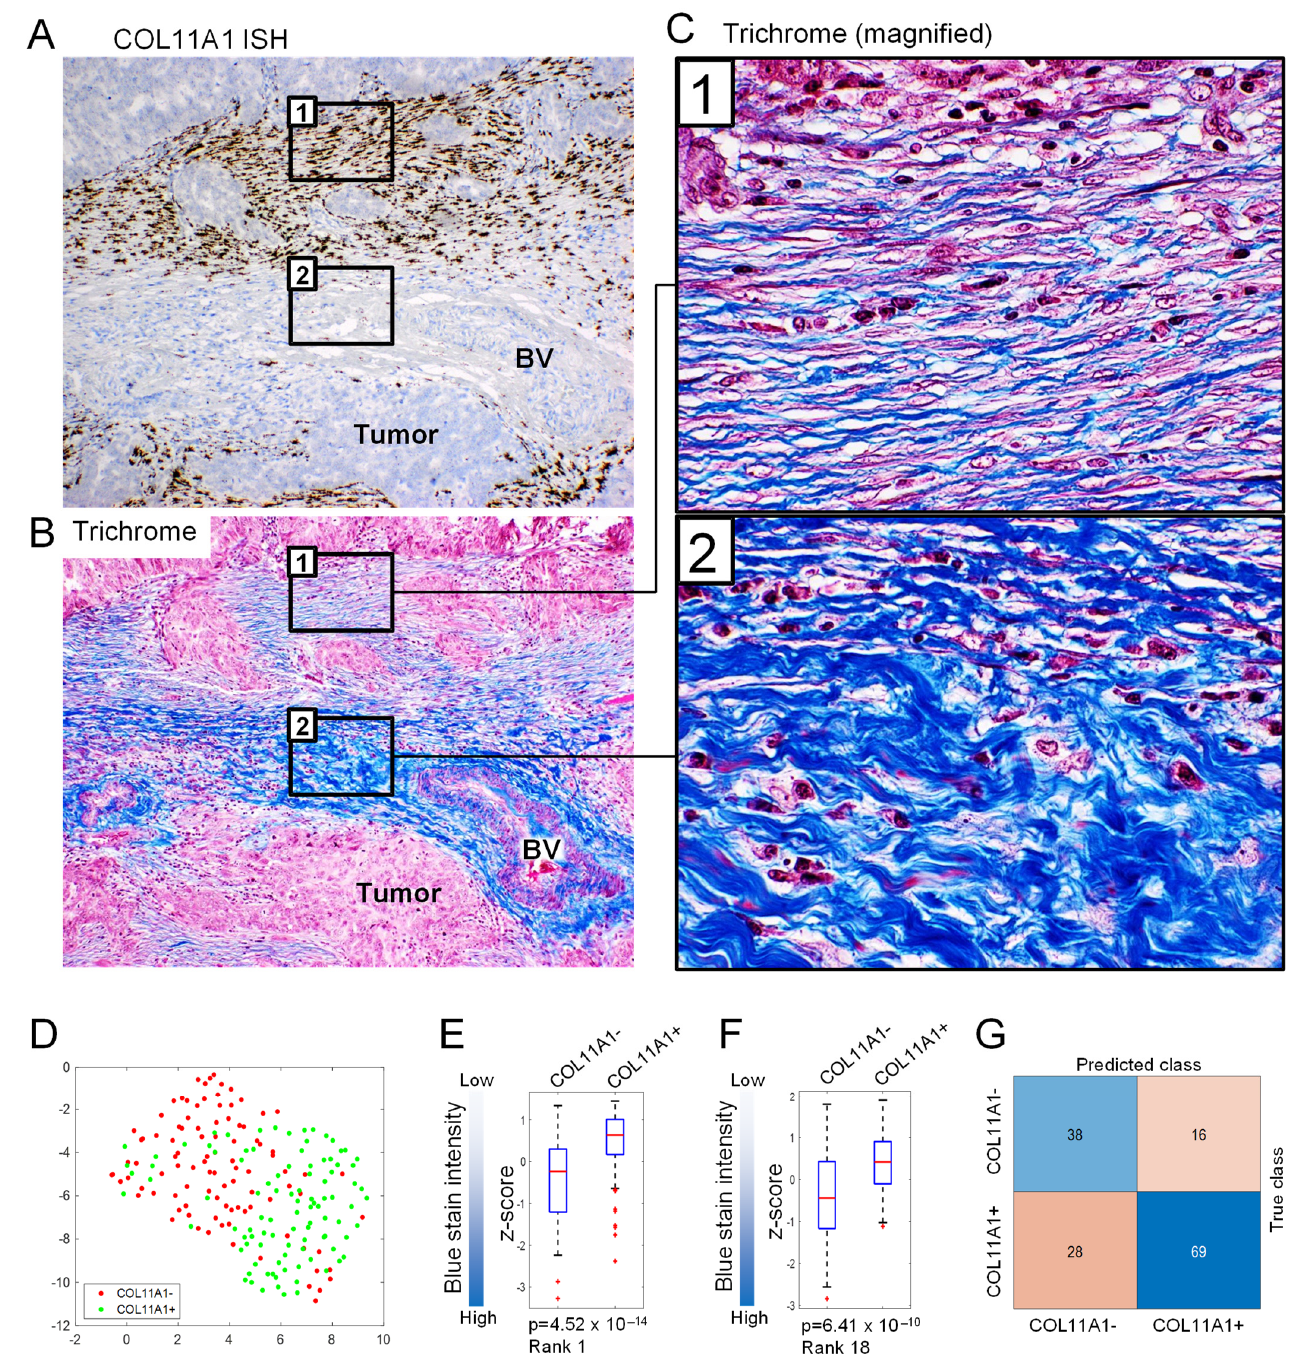
Figure 5. COL11A1 + ECM exhibits altered texture and organization. Tumor sections were processed for ( A ) COL11A1 ISH and ( B ) Masson’s trichrome staining. ( C ) COL11A1 + ECM (rectangles labeled [1] in A and B) contains thin linear collagen fibers while COL11A1 − ECM (rectangles labeled [2] in A and B) contains thick curly collagen fibers. ISH, in situ hybridization; BV, blood vessel. ( D ) UMAP plot of images characterized by the 50 differentially expressed features identified by statistical analysis of the discovery set of Masson’s trichrome tiles with known COL11A1 status. ( E , F ) Examples of expression boxplots for two mean blue intensity features quantitated in ( E ) image areas with strong staining (an SFTA feature) and ( F ) the entire image. ( G ) Confusion matrix showing predicted COL11A1 positivity in the validation set of Masson’s trichrome images. The classifier correctly predicted COL11A1 + and COL11A1 − scores in 107/151 images (70.86% accuracy).